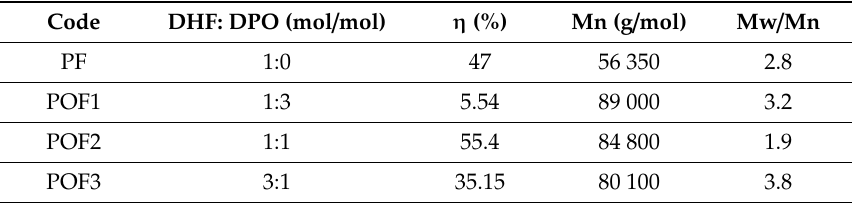
Table 1. Reaction yield and molecular weight of the polymers obtained for different molar ratios of the DFH/DPO monomers.